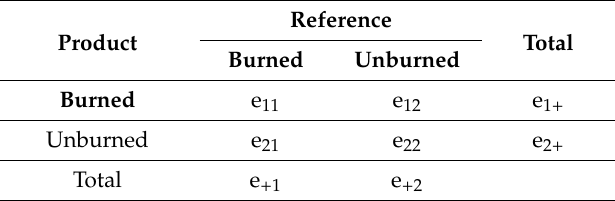
Table 2. Sampled error matrix on a sampling unit